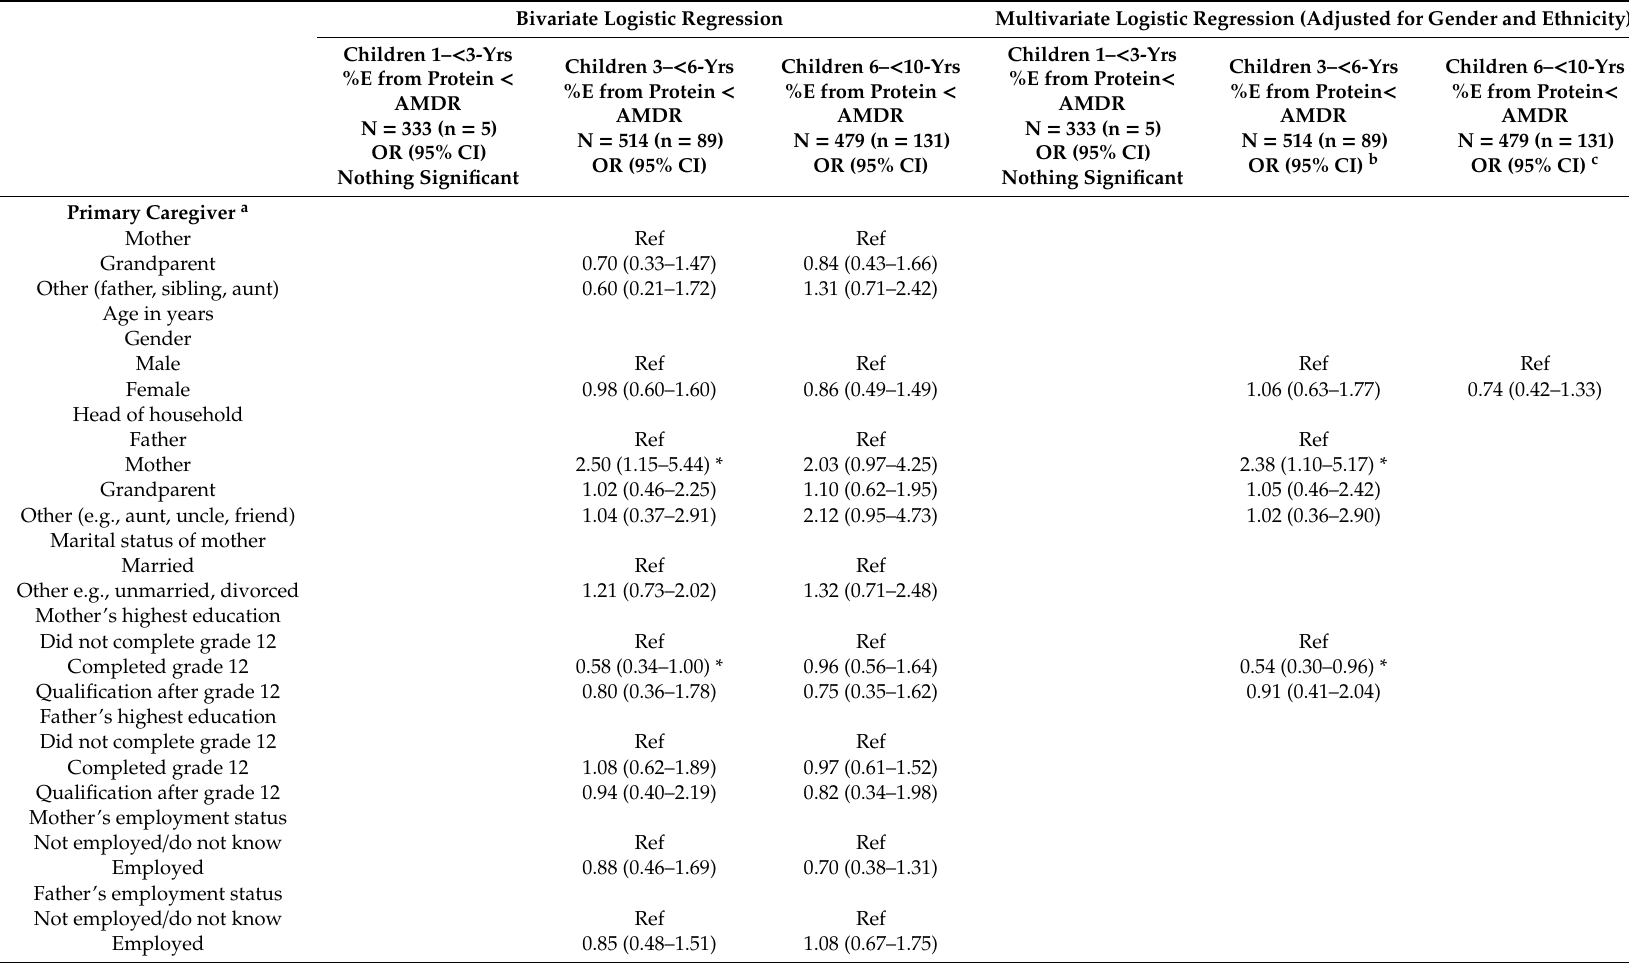
Table 8. Bivariate and multivariate logistic regression of sociodemographic factors on having a protein intake below the acceptable macronutrient distribution range (AMDR) by age